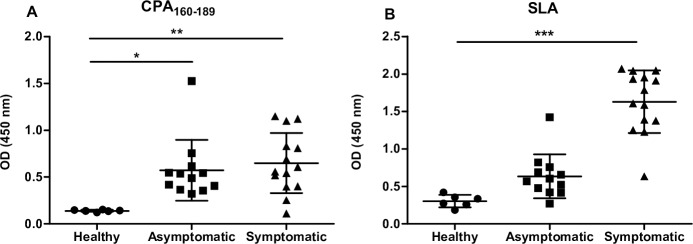
Evaluation of CPA160-189 immunogenicity in naturally infected dogs.Detection of (A) CPA160-189- and (B) SLA-specific IgG antibodies in sera samples from asymptomatic (n = 12) and symptomatic (n = 14) L. infantum-infected and non-infected healthy (n = 6) dogs. Lines indicate the mean±SD.